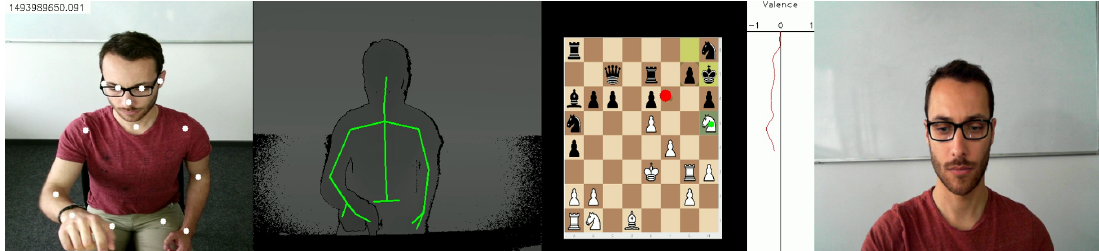
Figure 1. Multimodal view of gathered data. Left to right: RGB (with body joints) and depth view from Kinect 2 sensors, screen record of chess task (red point is current position of gaze, green point is position of last mouse click), plot of current level of positive emotion expression (valence) and frontal view of face from webcam sensor.